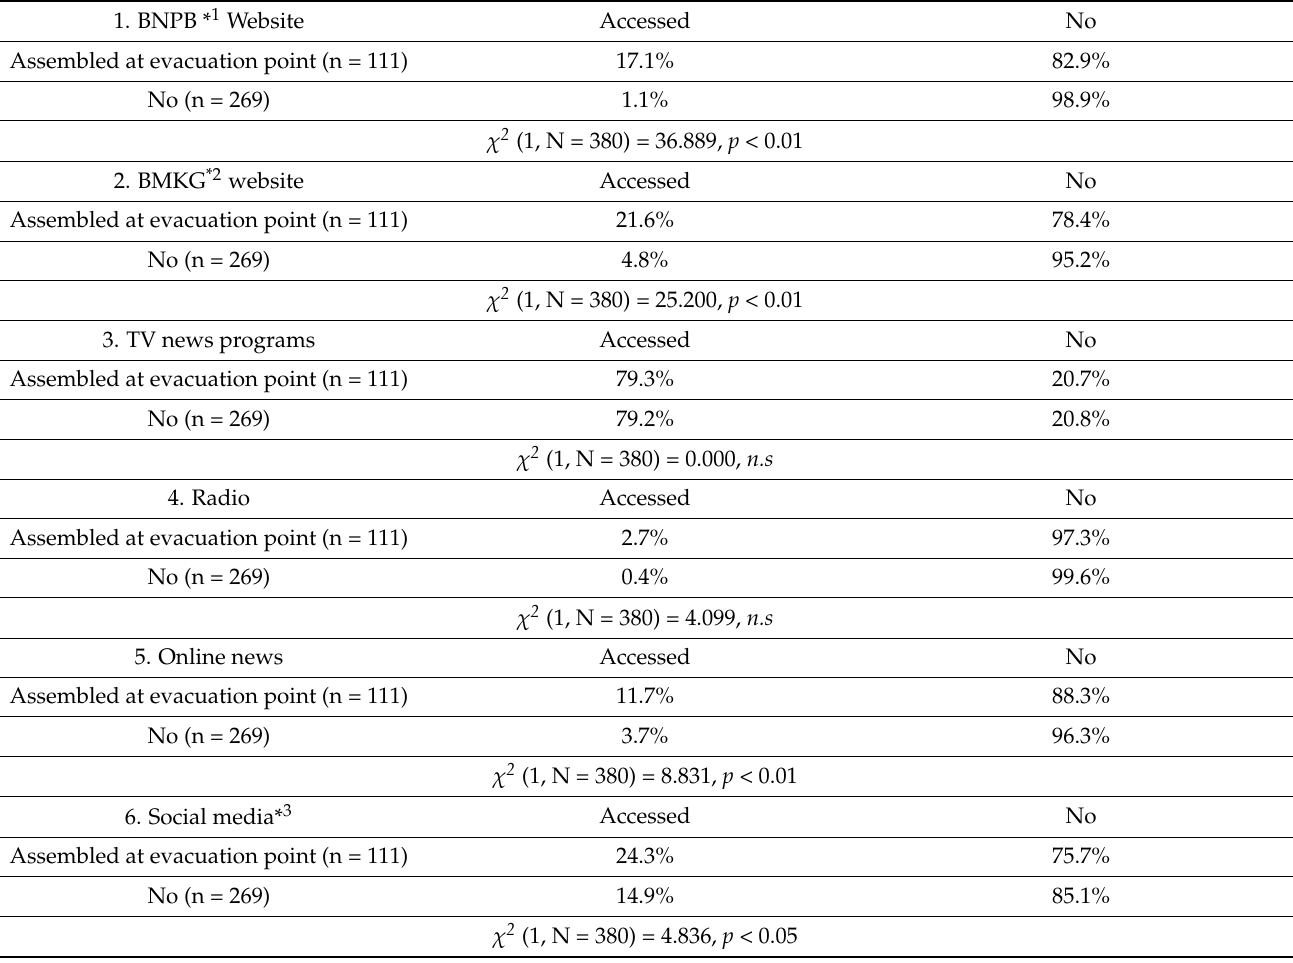
Table 11. Information access after the earthquake (N =